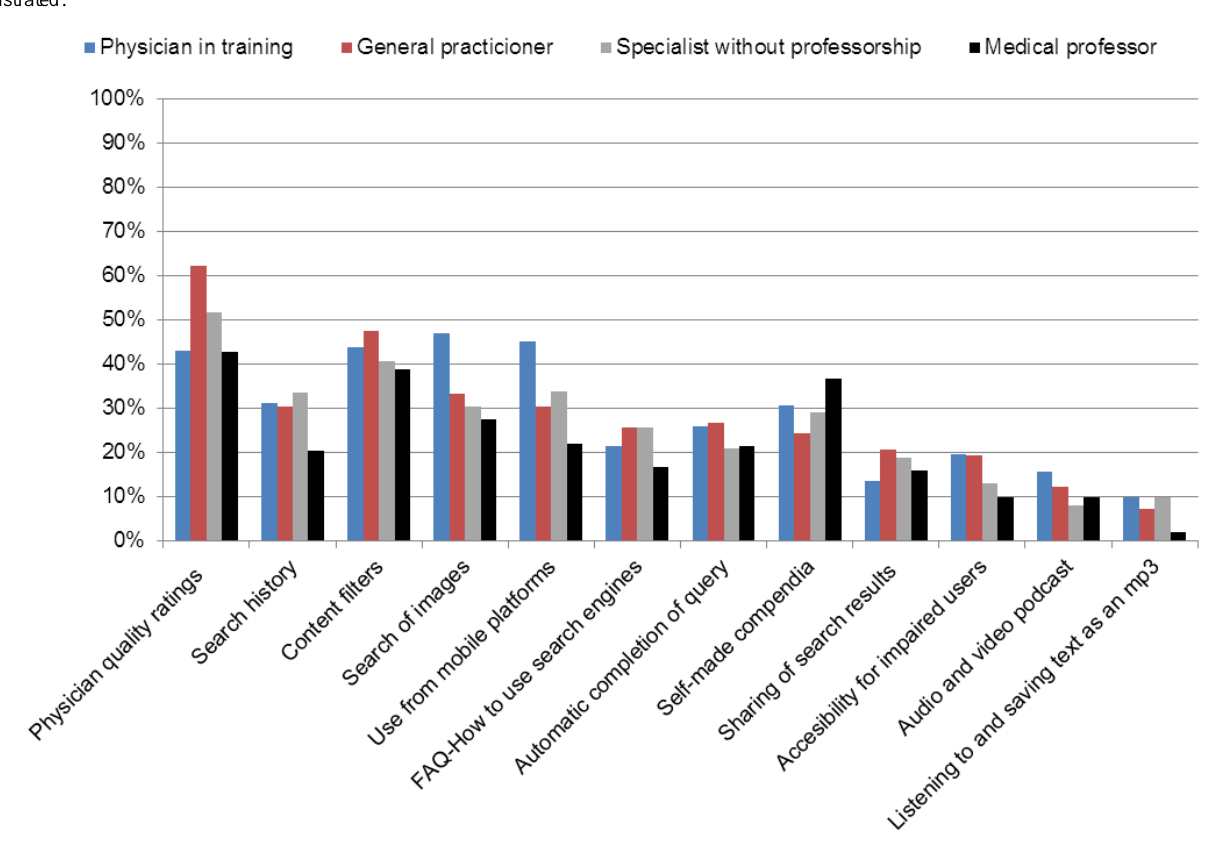
Figure 2. Responses to the question "How important do you perceive the following tools?", percentages of responses with the answer "Important" are